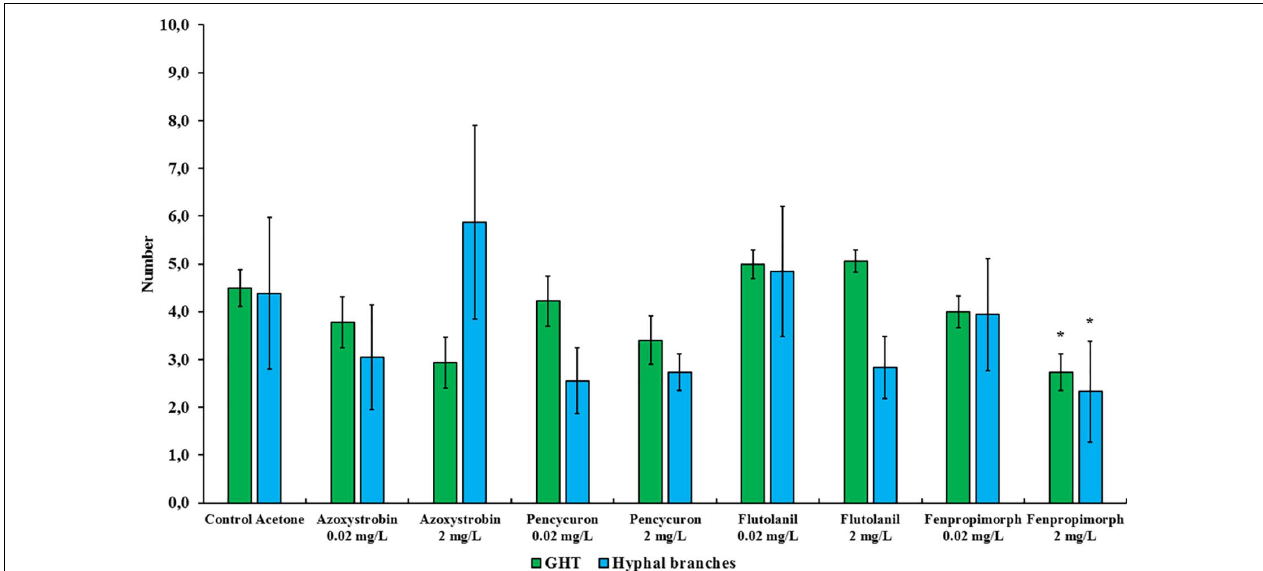
FIGURE 3 | Number of growing hyphal tips (GHTs) and their hyphal branches produced in the hyphal healing mechanism (HHM) of Rhizophagus irregularis MUCL 41833 in absence (control acetone) or in presence of increasing concentrations of azoxystrobin, pencycuron, flutolanil and fenpropimorph (0.02 and 2 mg L − 1 ). Data were obtained 48 h after hyphal physical injury and addition of MSR medium containing or not the fungicide at the place of hyphal injury. Kruskal-Wallis followed by a Dunn multiple comparison post hoc test was performed to validate significant difference between fungicides treatments and their respective control acetone: *, **, and *** indicate P < 0.05; 0.01 and 0.001, respectively. P -values below 0.05 are significant.